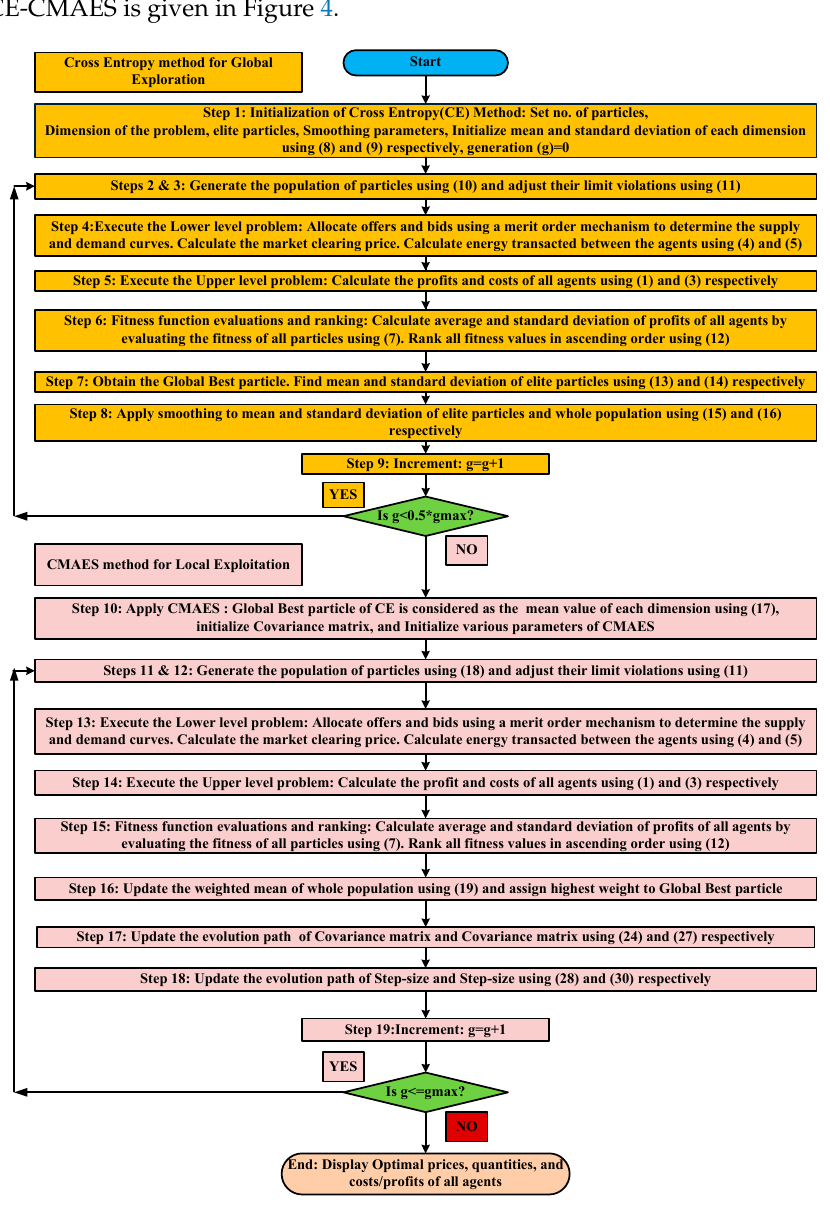
Figure 4. Flowchart of CE-CMAES